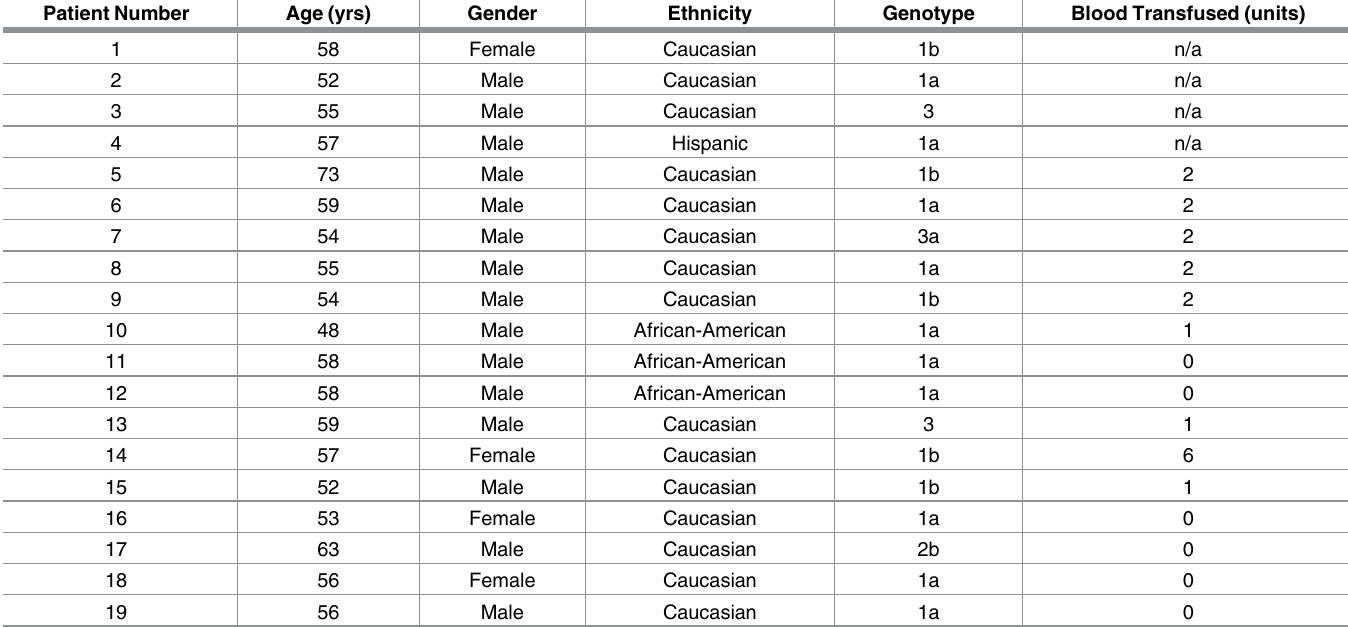
Table 1. Patient demographics.